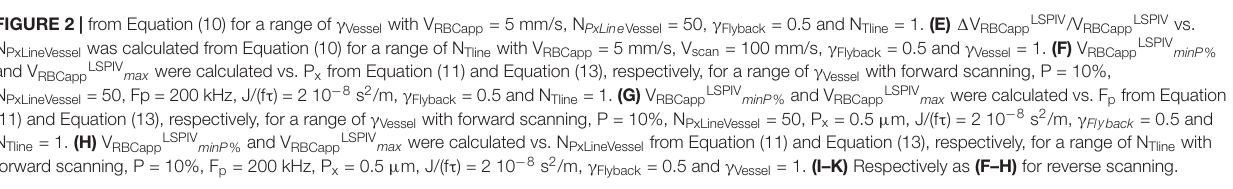
FIGURE 2 | from Equation (10) for a range of γ Vessel with V RBCapp = 5 mm/s, N PxLine Vessel = 50, γ Flyback = 0.5 and N Tline = 1. (E) (cid:49) V RBCappLSPIV /V RBCappLSPIV vs. N PxLineVessel was calculated from Equation (10) for a range of N Tline with V RBCapp = 5 mm/s, V scan = 100 mm/s, γ Flyback = 0.5 and γ Vessel = 1. (F) V RBCappLSPIV minP % and V RBCappLSPIV max were calculated vs. P x from Equation (11) and Equation (13), respectively, for a range of γ Vessel with forward scanning, P = 10%, N PxLineVessel = 50, Fp = 200 kHz, J/(f τ ) = 2 10 − 8 s 2 /m, γ Flyback = 0.5 and N Tline = 1. (G) V RBCappLSPIV minP % and V RBCappLSPIV max were calculated vs. F p from Equation (11) and Equation (13), respectively, for a range of γ Vessel with forward scanning, P = 10%, N PxLineVessel = 50, P x = 0.5 µ m, J/(f τ ) = 2 10 − 8 s 2 /m, γ Flyback = 0.5 and N Tline = 1. (H) V RBCappLSPIV minP % and V RBCappLSPIV max were calculated vs. N PxLineVessel from Equation (11) and Equation (13), respectively, for a range of N Tline with forward scanning, P = 10%, F p = 200 kHz, P x = 0.5 µ m, J/(f τ ) = 2 10 − 8 s 2 /m, γ Flyback = 0.5 and γ Vessel = 1. (I–K) Respectively as (F–H) for reverse